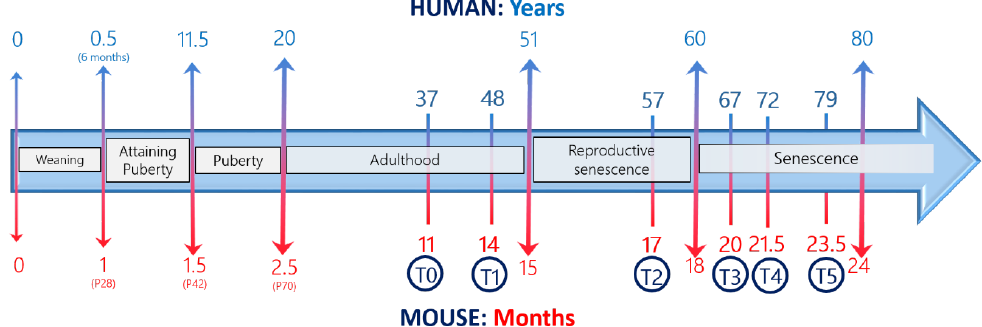
Figure 1. Comparative age between men and mice during their life span and the chosen experimental times (modified by Dutta and Sengupta,